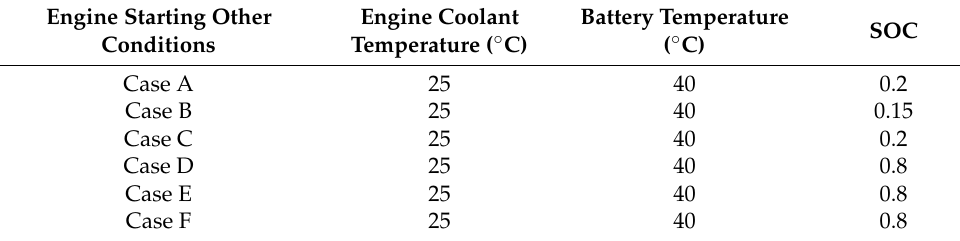
Figure 18. Engine starting condition points. Table 3. Engine Starting Other Conditions. Table 2. Engine Starting Other